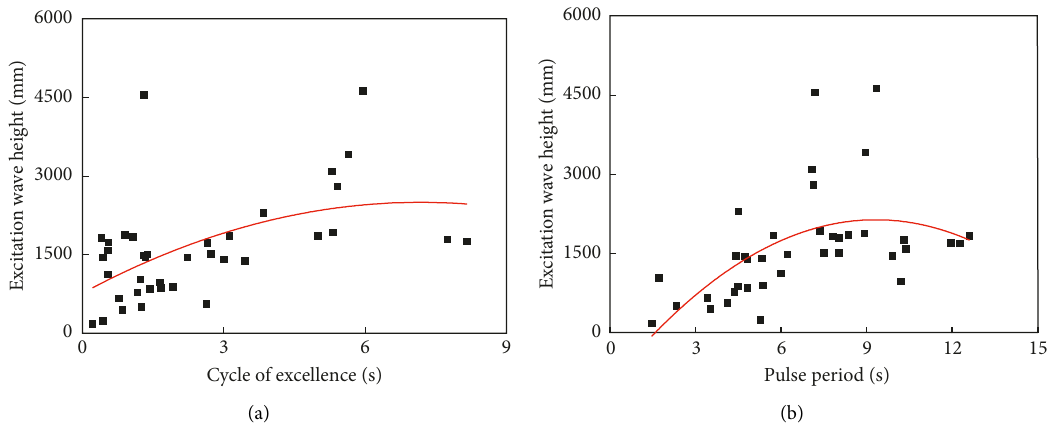
Figure 8: Spectrum parameters of near-fault ground motion and wave height scatter plot. (a) Trend map of predominant period and wave height. (b) Trend chart of pulse period and wave